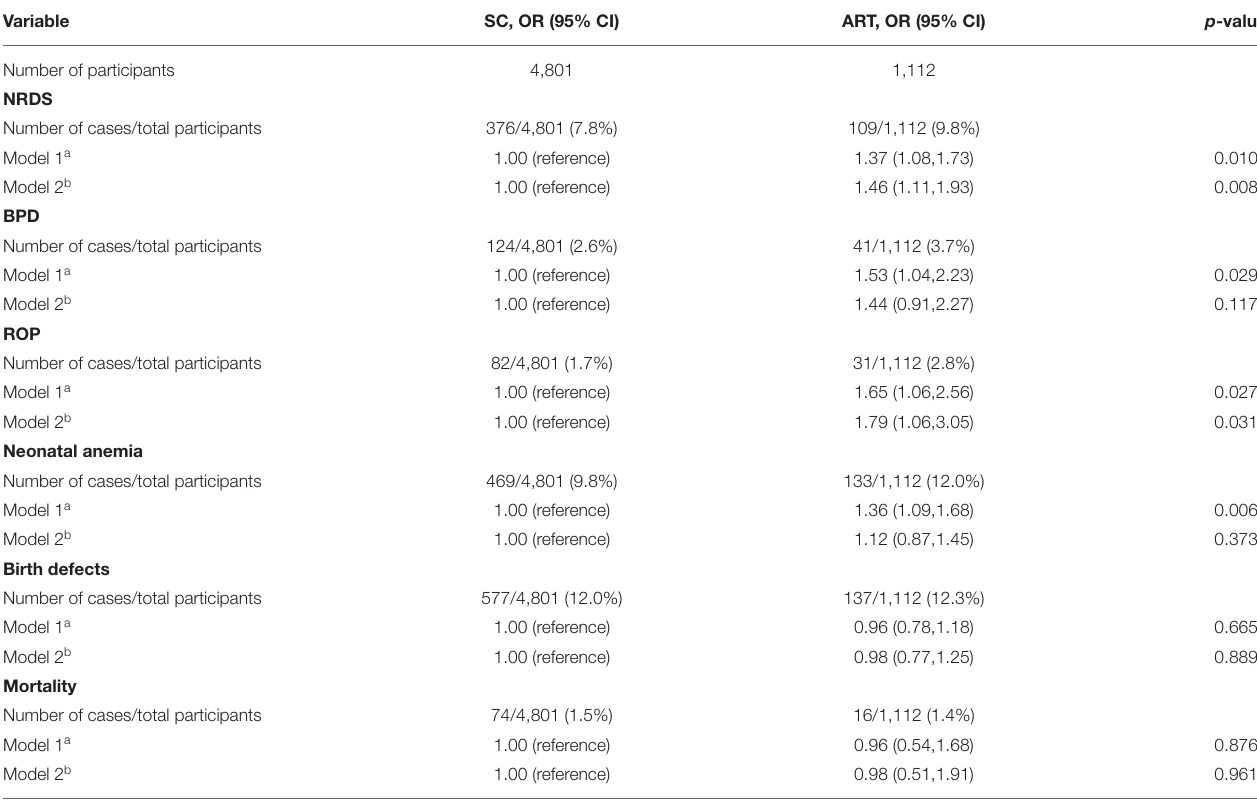
TABLE 4 | Association of ART with adverse neonatal outcomes.